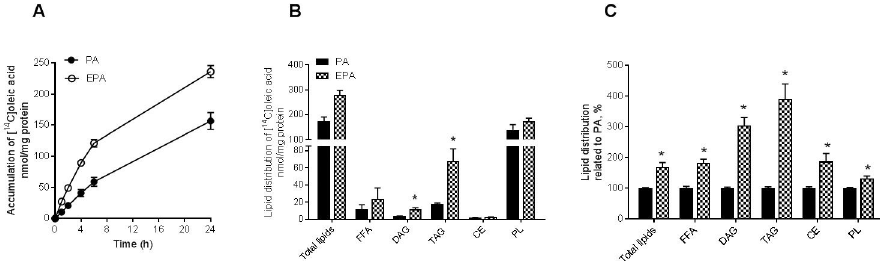
Fig 1. Accumulation and distribution of oleic acid in myotubes when co-incubated with fatty acids. Human myotubes were grown and differentiated in 96-well ScintiPlate or 12-well tissue culture plates. On day 6 of differentiation the myotubes were treated with a mixture of 100 μ M fatty acids for 24 h. The mixture was trace amounts of [ 14 C]OA (9 μ M) and non-labeled PA (16:0) or EPA (20:5, n-3) (91 μ M). (A) Cell-associated radioactivity was measured during 24 h by SPA. Real-time accumulation of radiolabel was monitored as described in Methods. Results represent mean ± SEM (nmol/mg protein) for n = 3 donors. Significant increase for EPA vs. PA